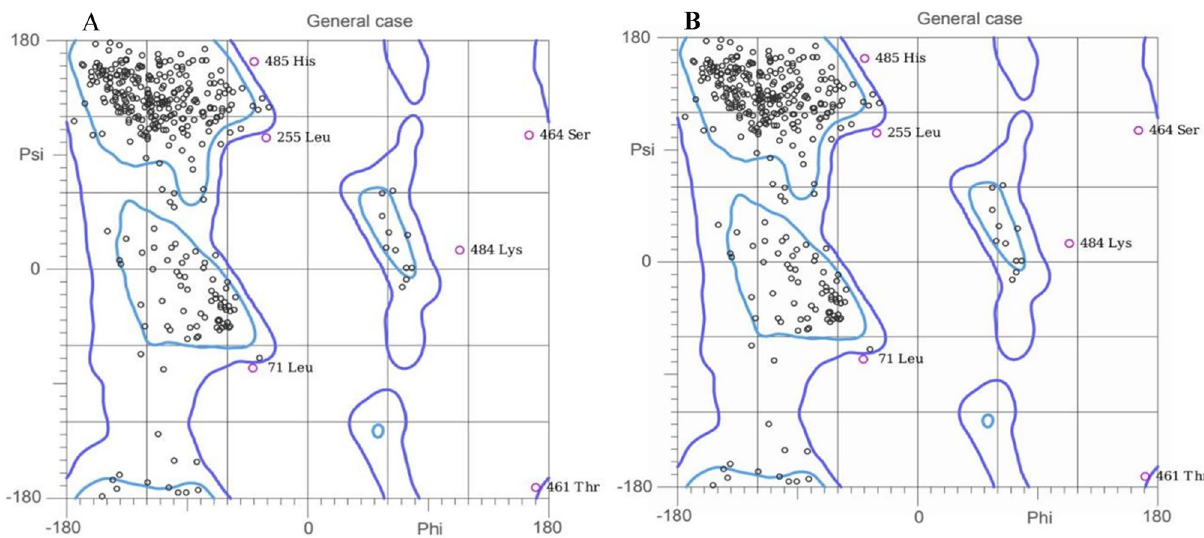
Figure 5. Representing the Ramachandran plot for wildtype c-kit protein model ( A ) and Ramachandran plot for mutant c-kit protein model ( B ) generated by